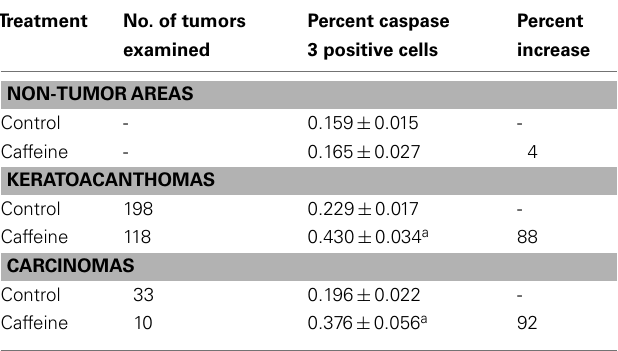
FIGURE 9 | Illustration of mitotic cells with caspase 3 or cyclin B1 staining .This figure shows representative mitotic cells with caspase 3 (left) or mitotic cells with cyclin B1 (right) positive staining (microscope